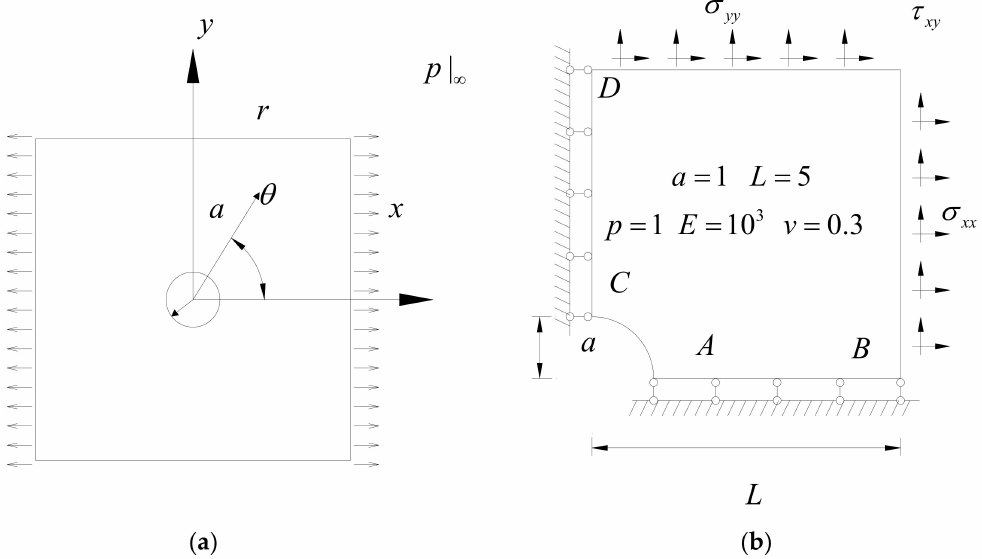
Figure 9. Infinite plate with a circular hole: ( a ) problem description; ( b ) quadrant numerical model.